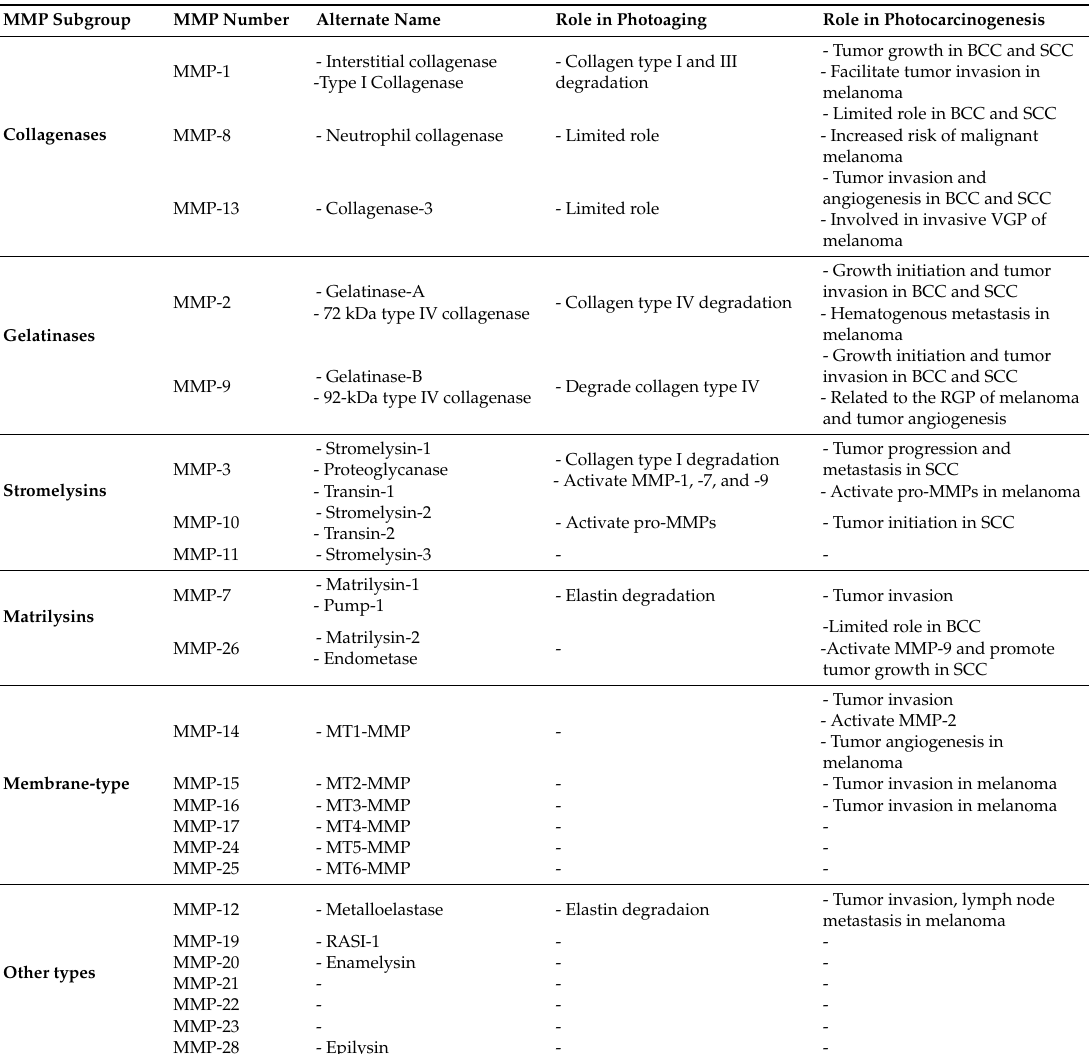
Table 1. Classification of human metalloproteinases (MMPs) and their function in relation to photoaging and